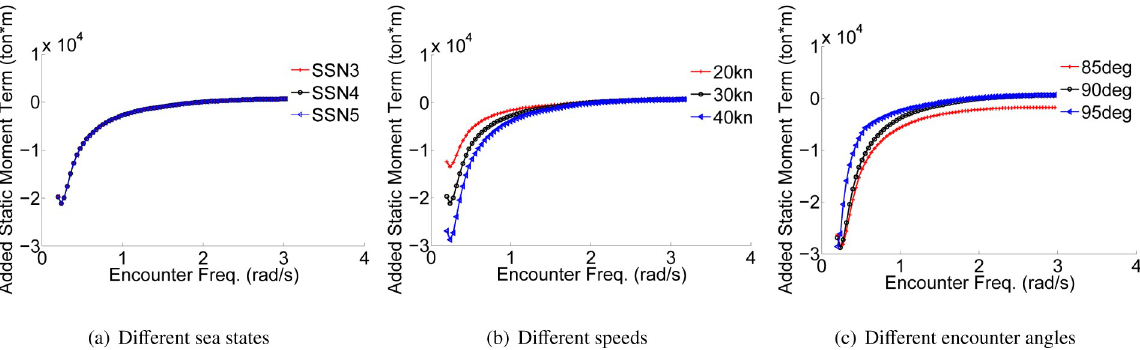
Fig 2. The longitudinal hydrodynamic parameters in different situations. (a) Different sea states. (b) Different speeds. (c) Different encounter angles.